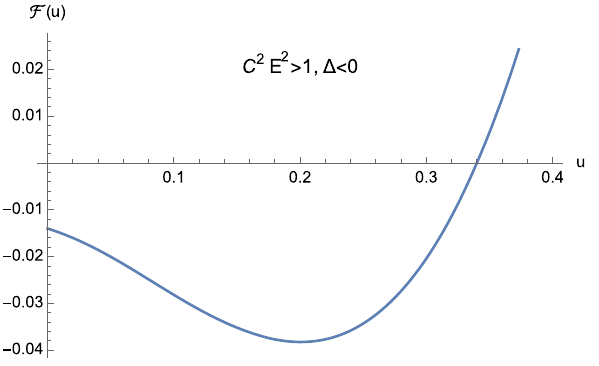
Fig. 11 The roots of Eq. (2.20) when C 2 E 2 = 1, (cid:9) = 0, and M (cid:9)=